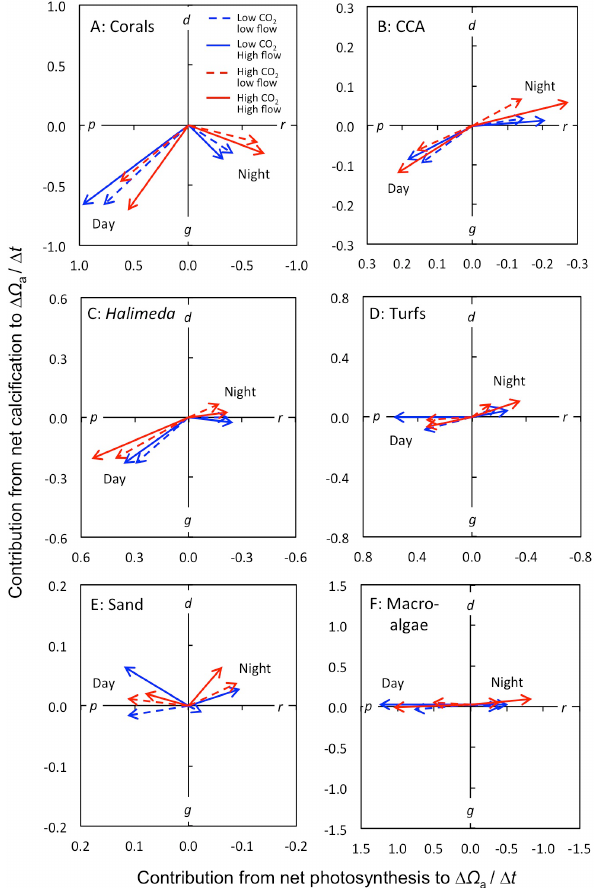
Fig. 7. Partitioning of contributions from net photosynthesis ( x axis) and net calcification ( y axis) to changes in aragonite saturation state ( 1(cid:127) a /1t for 1m water depth) depicted in Fig. 6. The contribution from net photosynthesis was calculated as bp n (corrected for air–sea CO 2 exchange) and the contribution from net calcification was cal- culated as g n ( b − 2 a ), forming the two terms in Eq. (5). The lengths of arrows are proportional to their contribution to 1(cid:127) a /1t . Note different scales on both axes and the reversed scale of the x axis. The symbols p , r , g and d denote the direction towards photosyn- thesis, respiration, calcification and calcium carbonate dissolution, consistent with C T and A T axes in Fig.